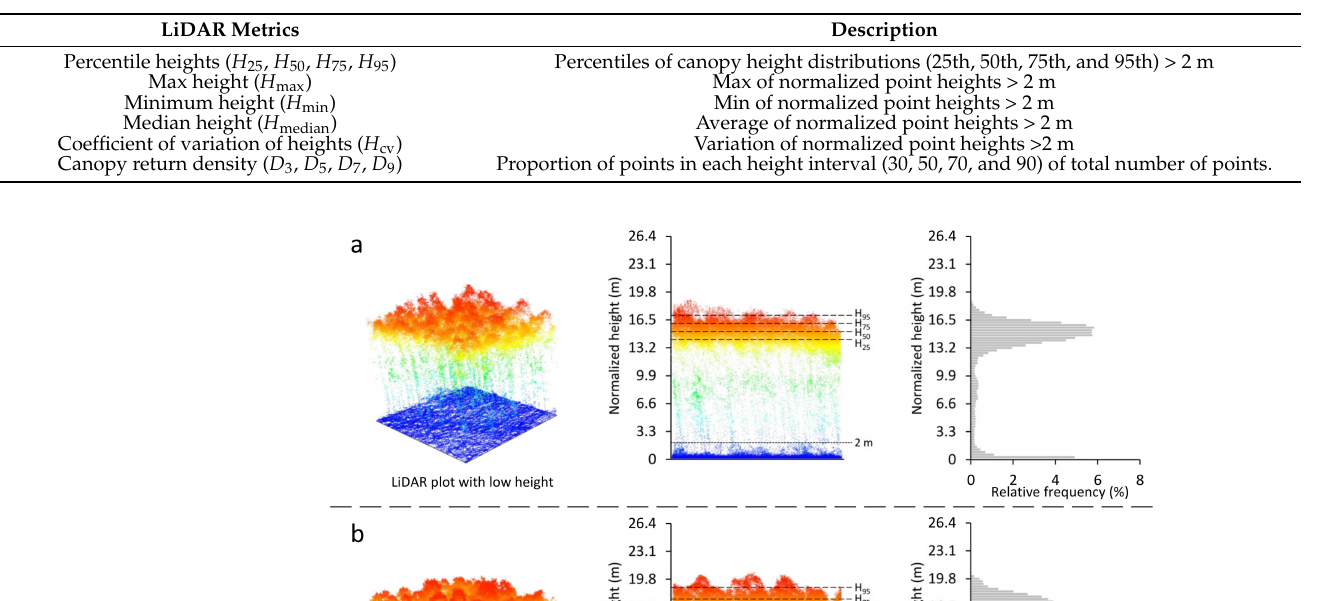
Table 2. A summary of LiDAR metrics obtained from UAV-LiDAR point clouds.